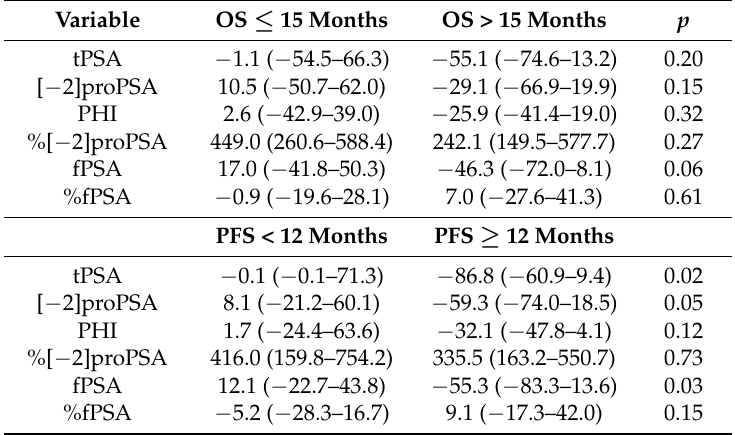
Figure 1. Relative median changes of PSA subforms at 8–12 weeks and at progression or last follow-up compared to baseline for ( a ) PFS < 12 months vs. ≥ 12 months; and ( b ) OS ≤ 15 months vs. >15 months. Table 2. Relative changes of median PSA-subform values (%) in 25 patients at 8–12 weeks for OS and PFS OS, overall survival; PFS, progression free